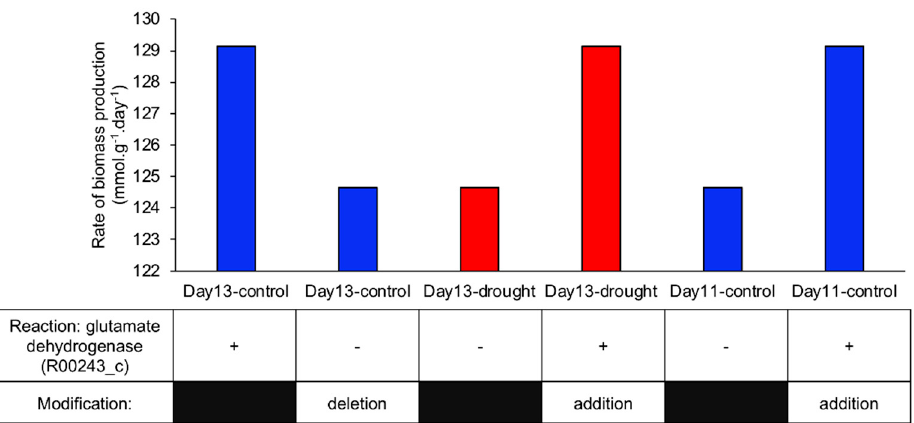
Figure 5. Importance of glutamate dehydrogenase (GDH) reaction for the increased biomass production rate in GEMs: Blue and red bars represent the biomass production rate calculated in the control and drought GEMs, respectively.